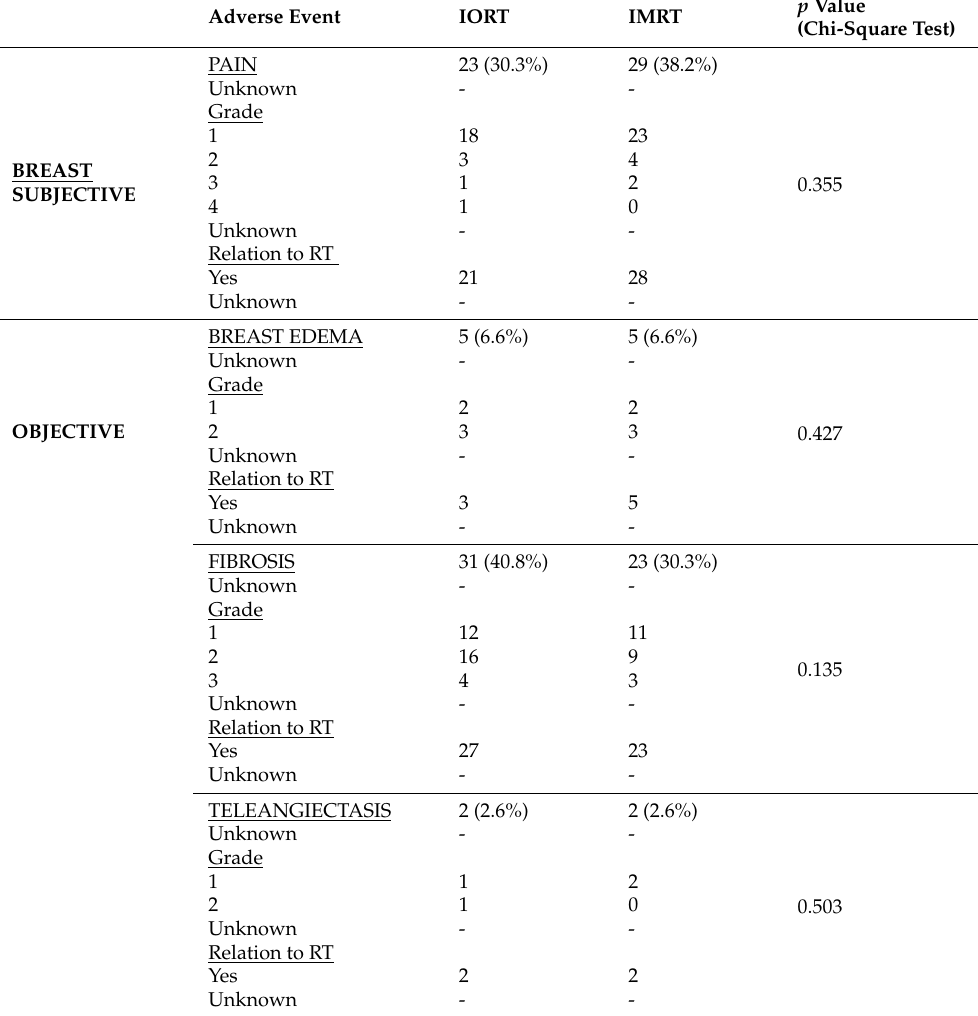
p Value (Chi-Square Test)